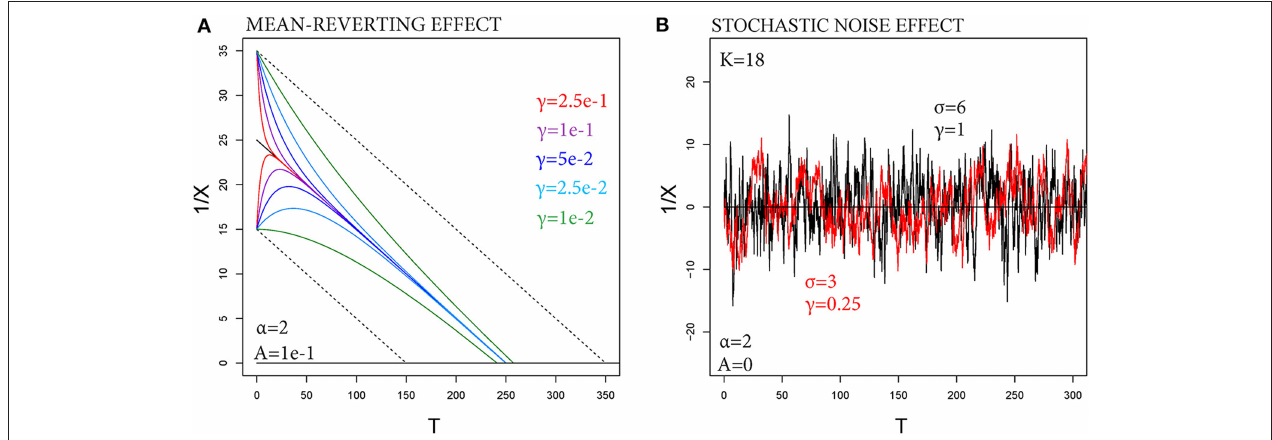
FIGURE 3 | (A) SDE solutions with α = 2, 1/X, with σ = 0, but δ ( t 0 ) > 0. Different colors correspond to different values of γ . (B) Ornstein-Uhlenbeck processes with equal K = σ 2 γ , but different ( σ , γ ).